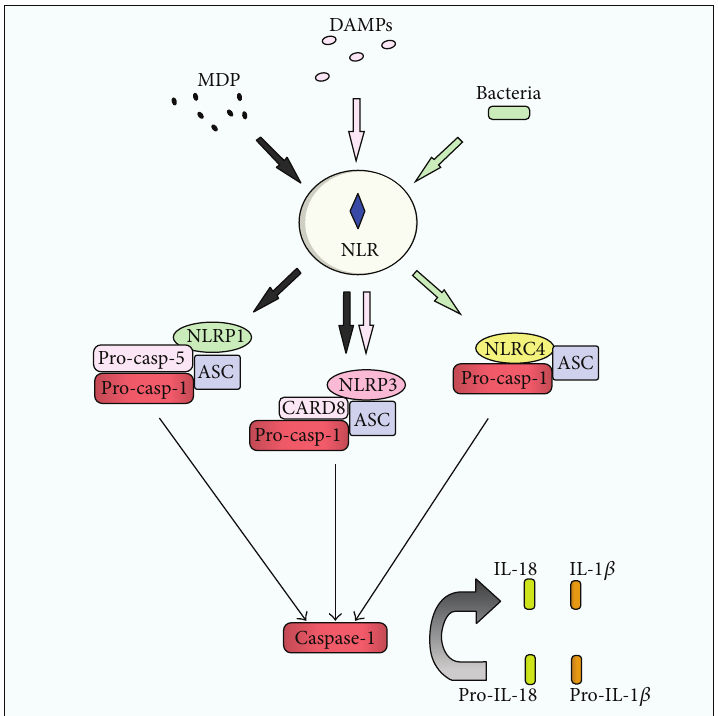
Figure 3: The inflammasome pathway. Depending on the type of stimulus and the type of cell or tissue, signaling through NLR proteins can activate different inflammasomes. Inflammasome is a multiprotein complex composed of NACHT LRR protein (NLRP) and apoptosis- associated speck-like protein containing CARD (ASC), which cleaves procaspase-1 (pro-casp-1) in caspase-1. Once activated, caspase-1 catalyzes the cleavage of pro-IL-18 and pro-IL-1 𝛽 into IL-18 and IL-1 𝛽 , respectively, promoting the inflammatory response.